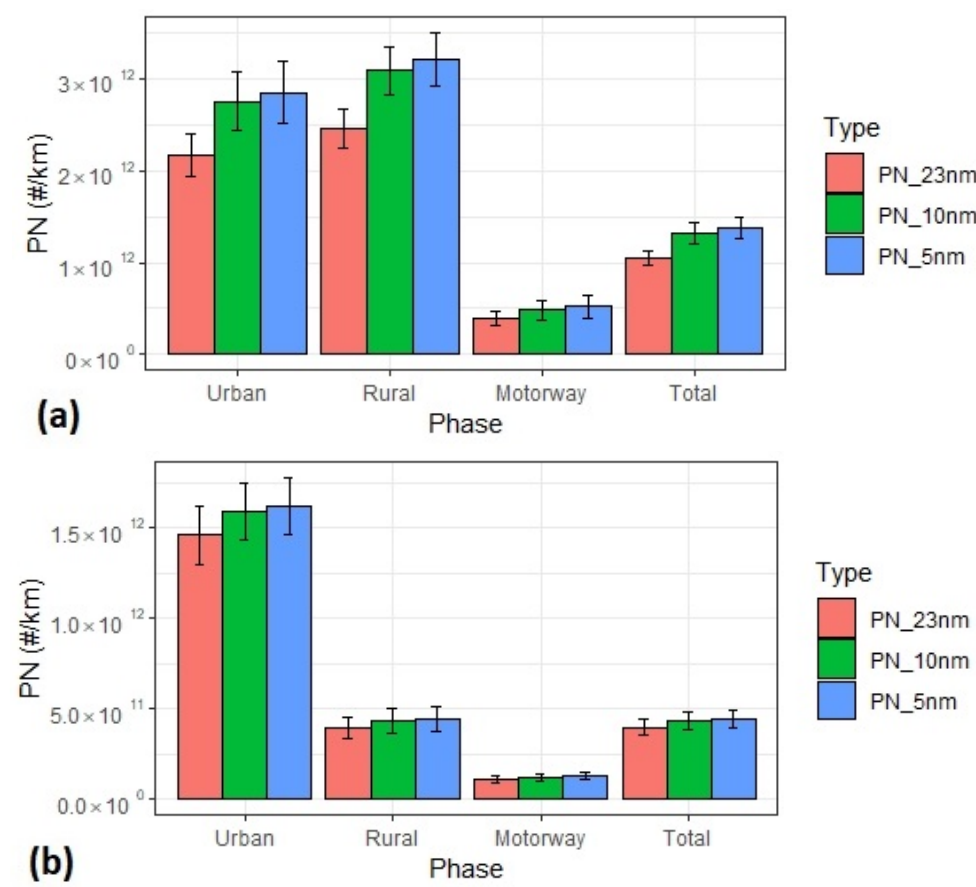
Figure 20. PN values comparing diameter cut-offs at 23 nm, 10 nm and 5 nm, across sections of ( a ) the WLTC and ( b ) the shortened RDE-style cycles. Error bars represent the standard error of the repeats (two tests for each WLTC phase, three tests for each RDE phase).